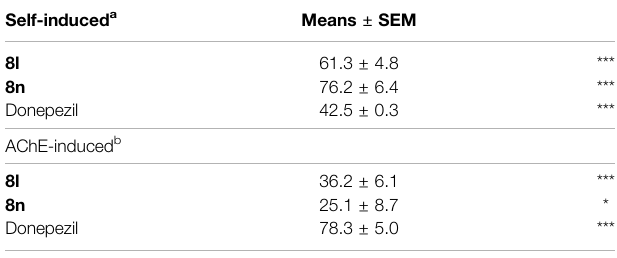
TABLE3| Inhibitionpotencyofthetargetcompounds( 8l and 8n )againstself-and AChE-induced A β 1-42 aggregation.